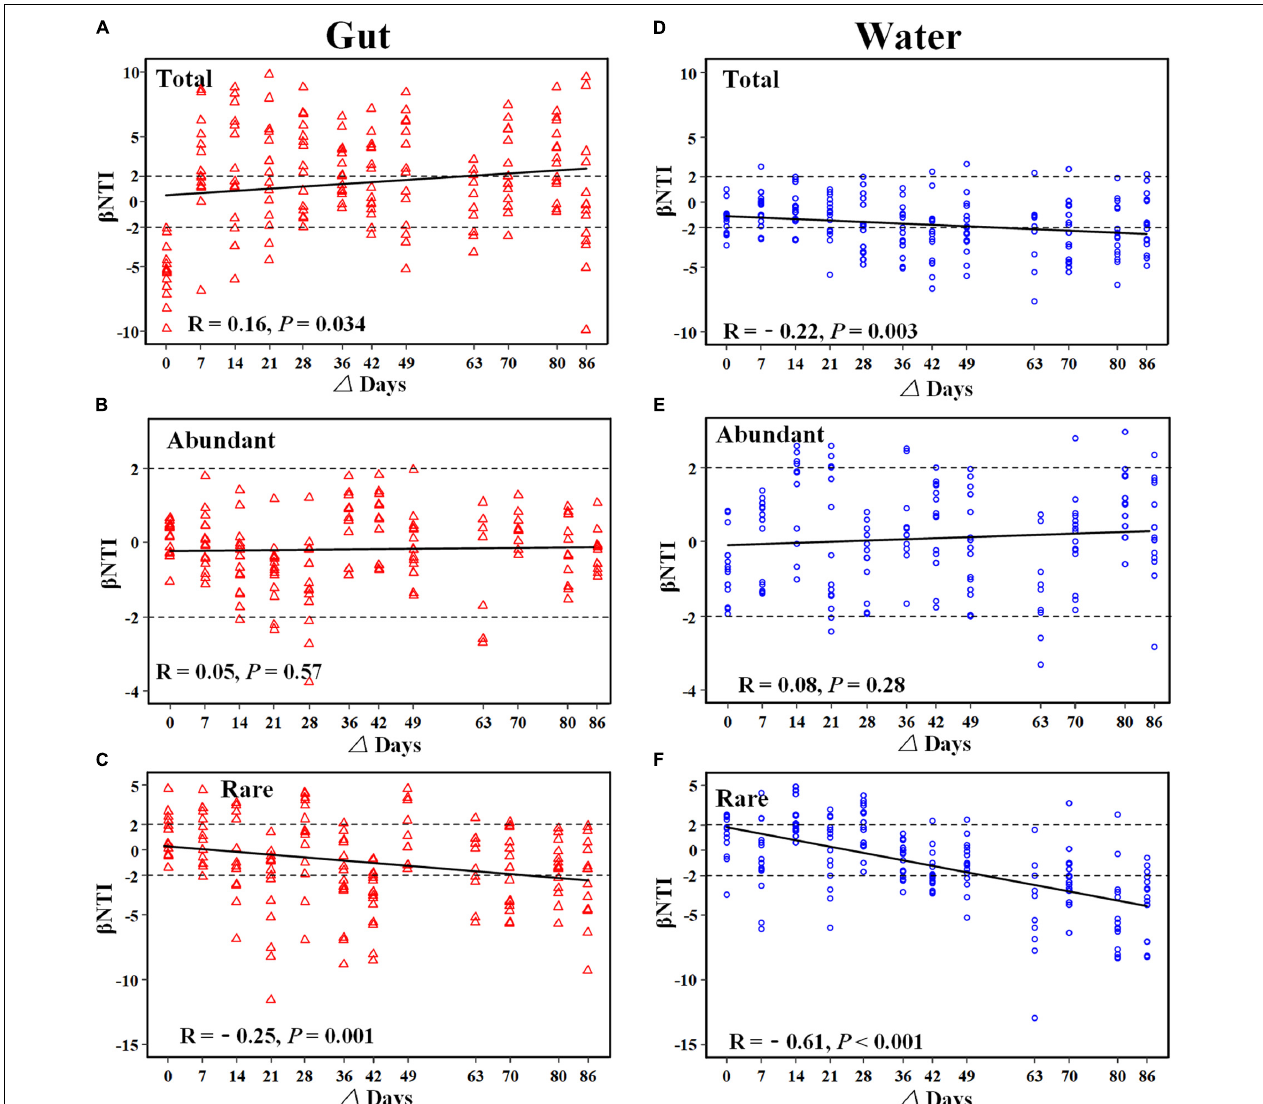
FIGURE 6 | Relationship between β NTI values of bacterial community over shrimp ontogeny. The horizontal dashed lines indicate the β NTI values of –2 and +2. An individual community below or above the two dashed lines indicates that determinism dominantly governs the community assembly, while between the two dashed lines indicates that stochasticity is dominant. The relationship between β NTI and differences in days gut microbiota (A–C) and bacterioplankton community (D–F) was fitted using linear